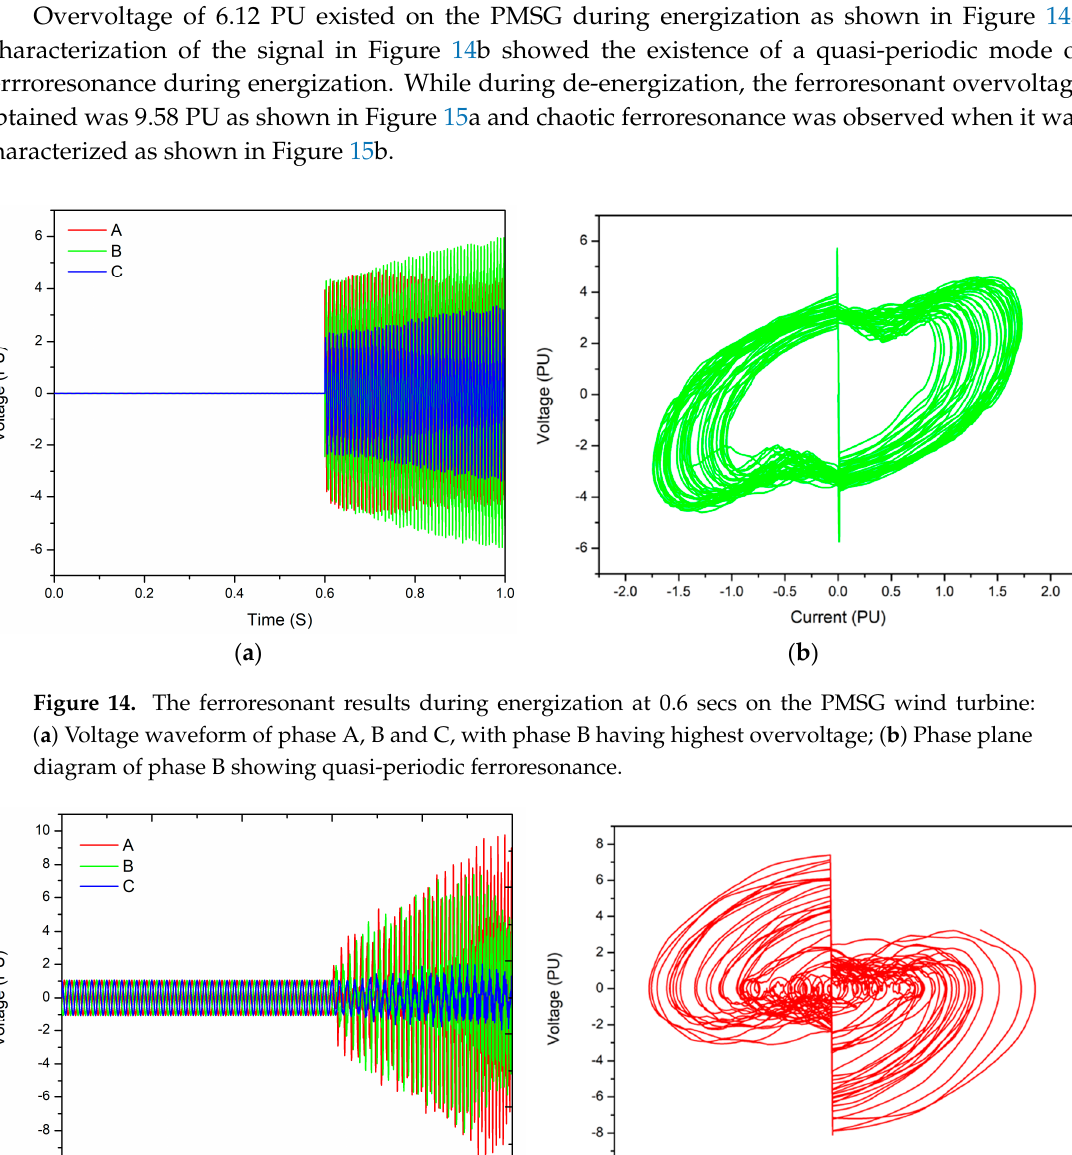
Figure 13. The ferroresonant results during de ‐ energization at 0.6 secs on the DFIG wind turbine: ( a ) Voltage waveform, with highest overvoltage on phase B; ( b ) Phase plane diagram of phase b showing chaotic mode.